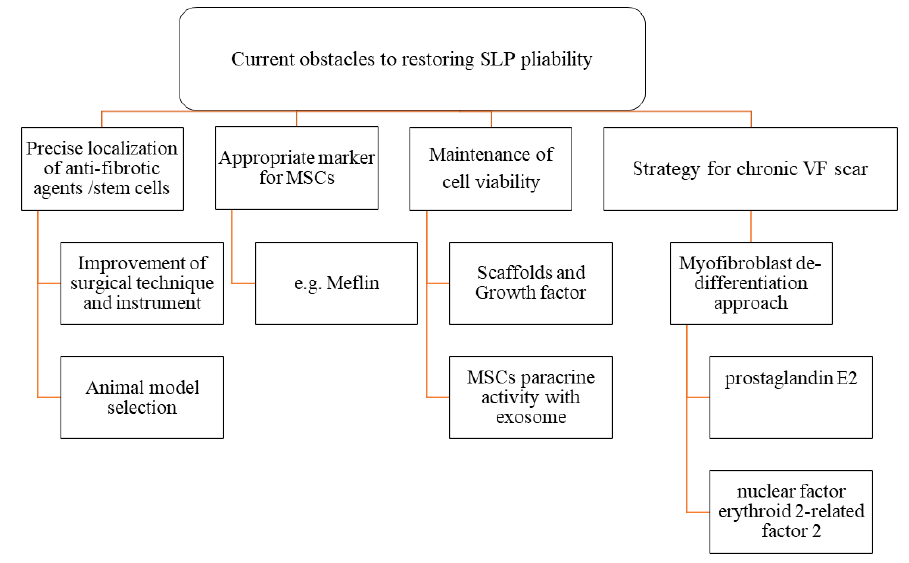
Figure 2. Organizational chart showing current obstacles to restoring VF pliability.